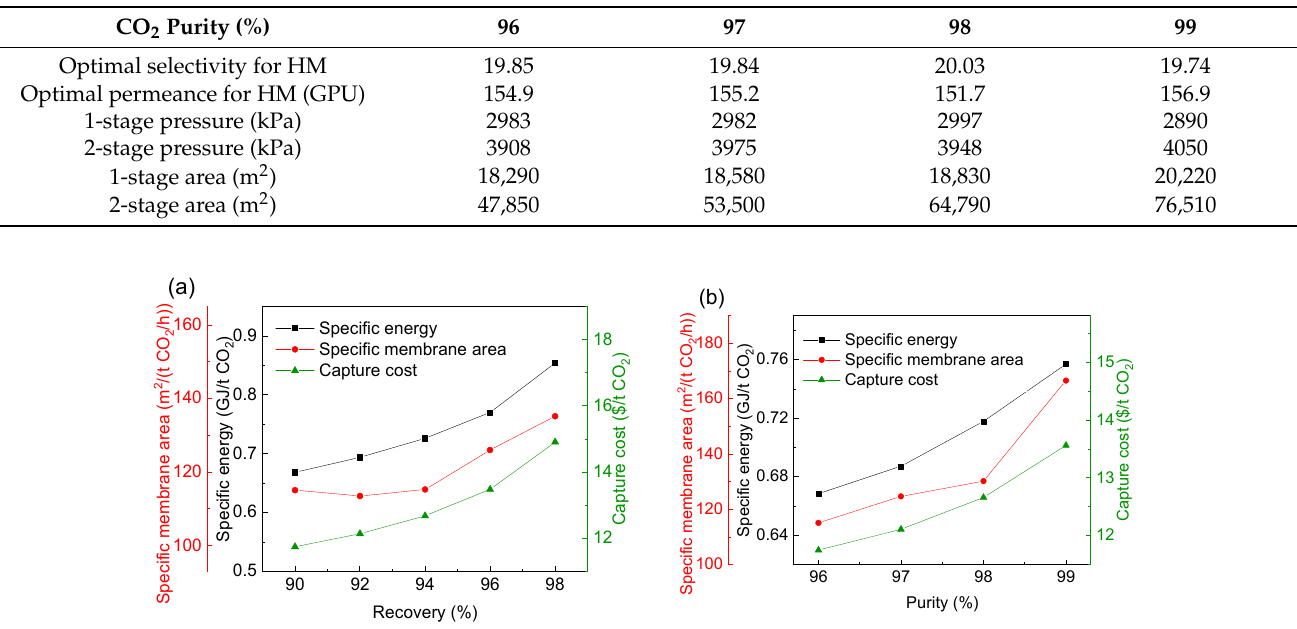
Figure 12. The optimal process when the performance of the H 2 ‐ selective membrane and CO 2 ‐ selec ‐ tive membrane changes based on the Robeson upper bound. With the increase of CO 2 recovery or purity, the change of the CO 2 capture cost, spe ‐ cific power consumption and membrane area of the optimal process are determined, as